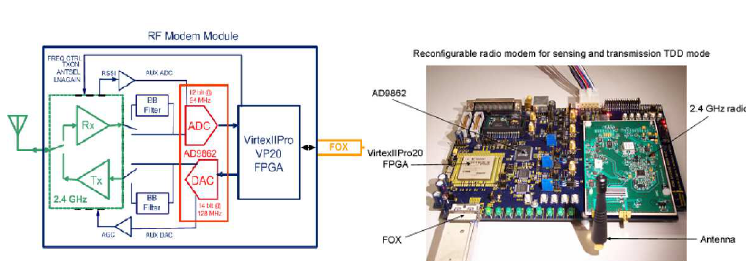
Figure 10. The BWRC Reconfigurable wireless